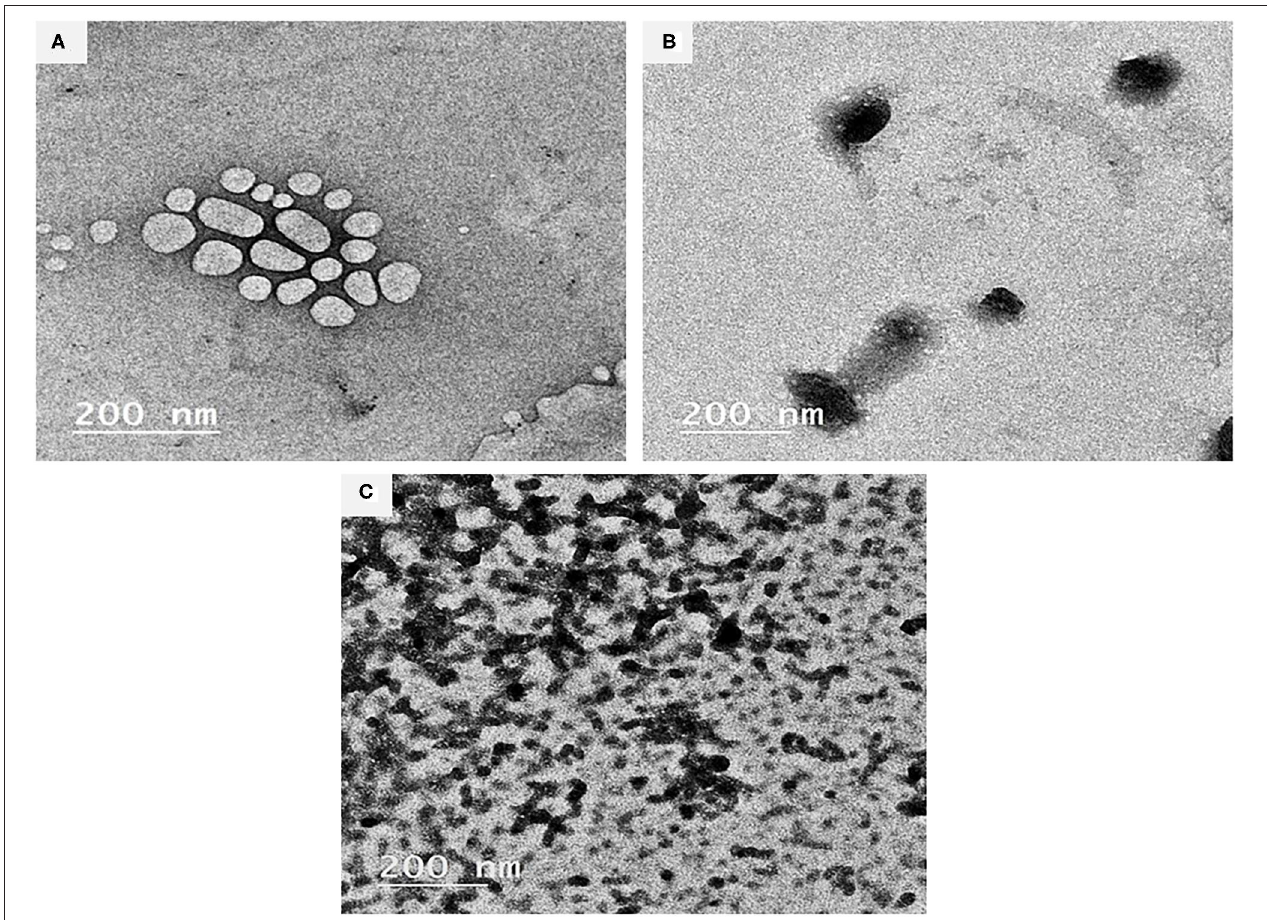
FIGURE 1 | Characterization of BSA-NPs via Transmission Electron Microscope (TEM). (A) Bovine Serum Albumin nanoparticles (BSA-NPs). (B) Iron Bovine Serum Albumin nanoparticles (Fe@ BSA-NPs). (C) Folic Acid Bovine Serum Albumin nanoparticles (FA@ BSA-NPs).